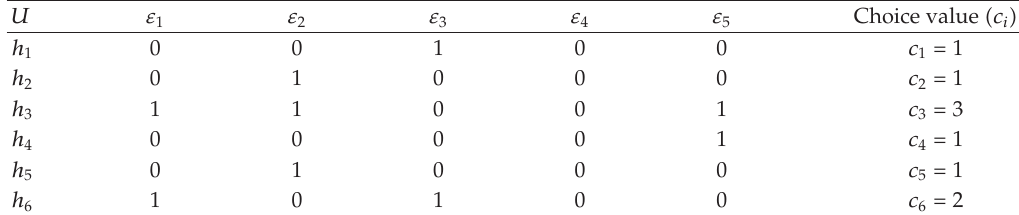
Table 8: Tabular representation of L (cid:5) S ; α (cid:6) ,λ (cid:6) (cid:6) with choice